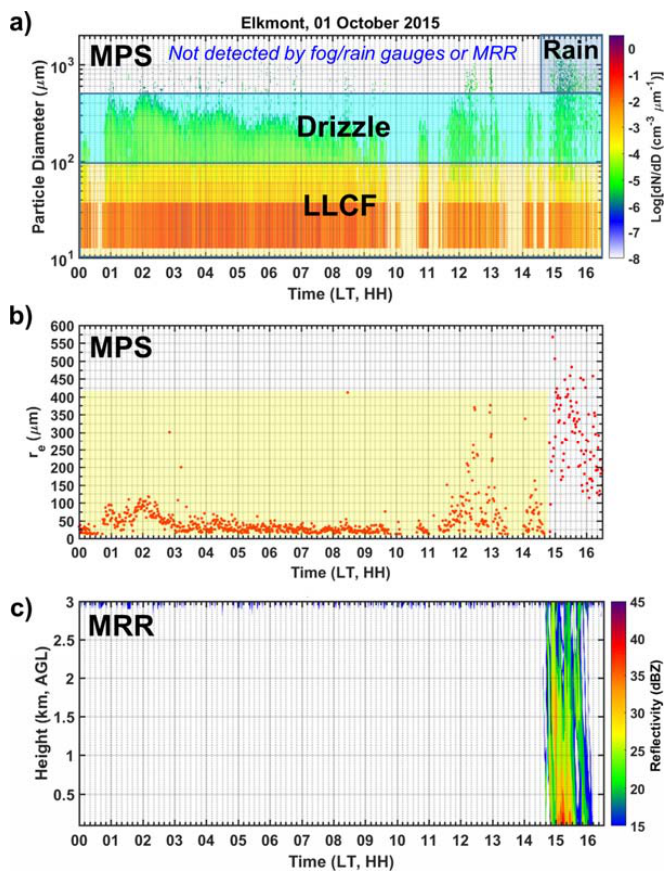
Figure 5. Time series of drop size distributions ( a ) from the meteorological particle spectrometer (MPS), droplet effective radius ( r e ; b ) derived from the MPS spectra, and reflectivity profiles ( c ) from a collocated Micro Rain Radar (MRR) at Elkmont on 1 October 2015. Note the shaded area in ( b ) highlights the period of fog presence.